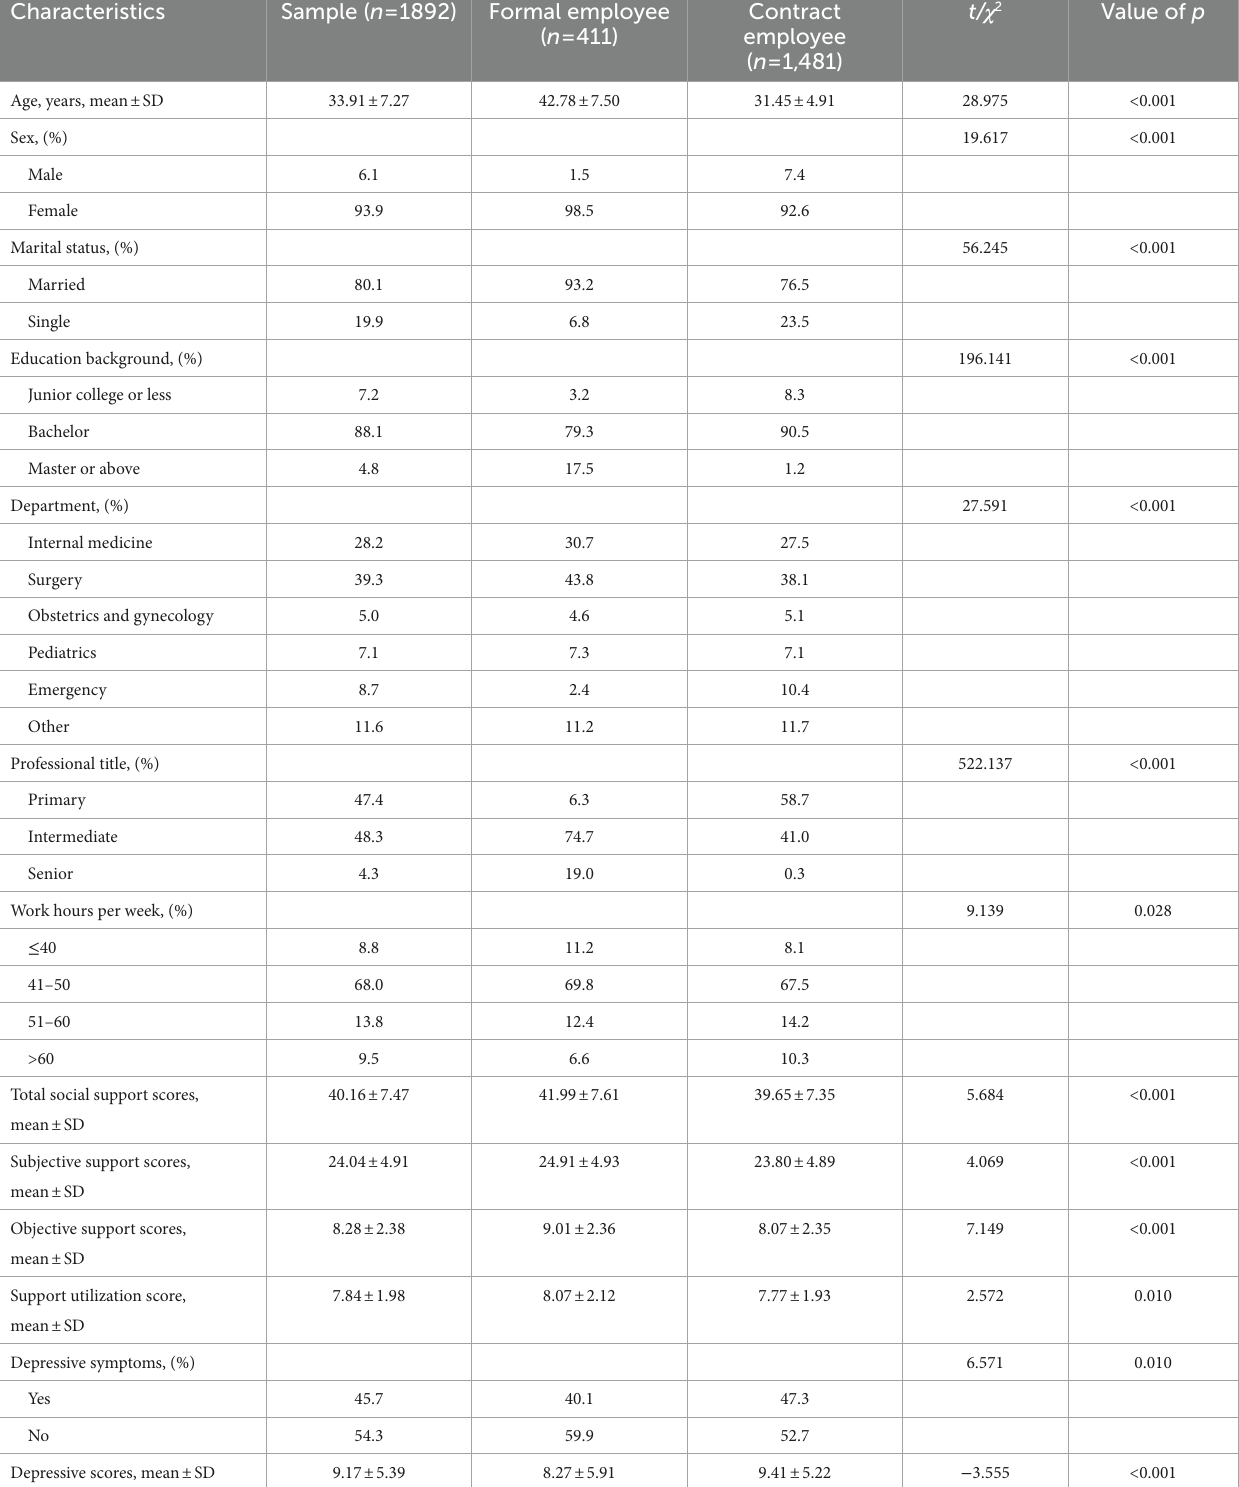
TABLE 1 Demographic characteristics according to employment type.